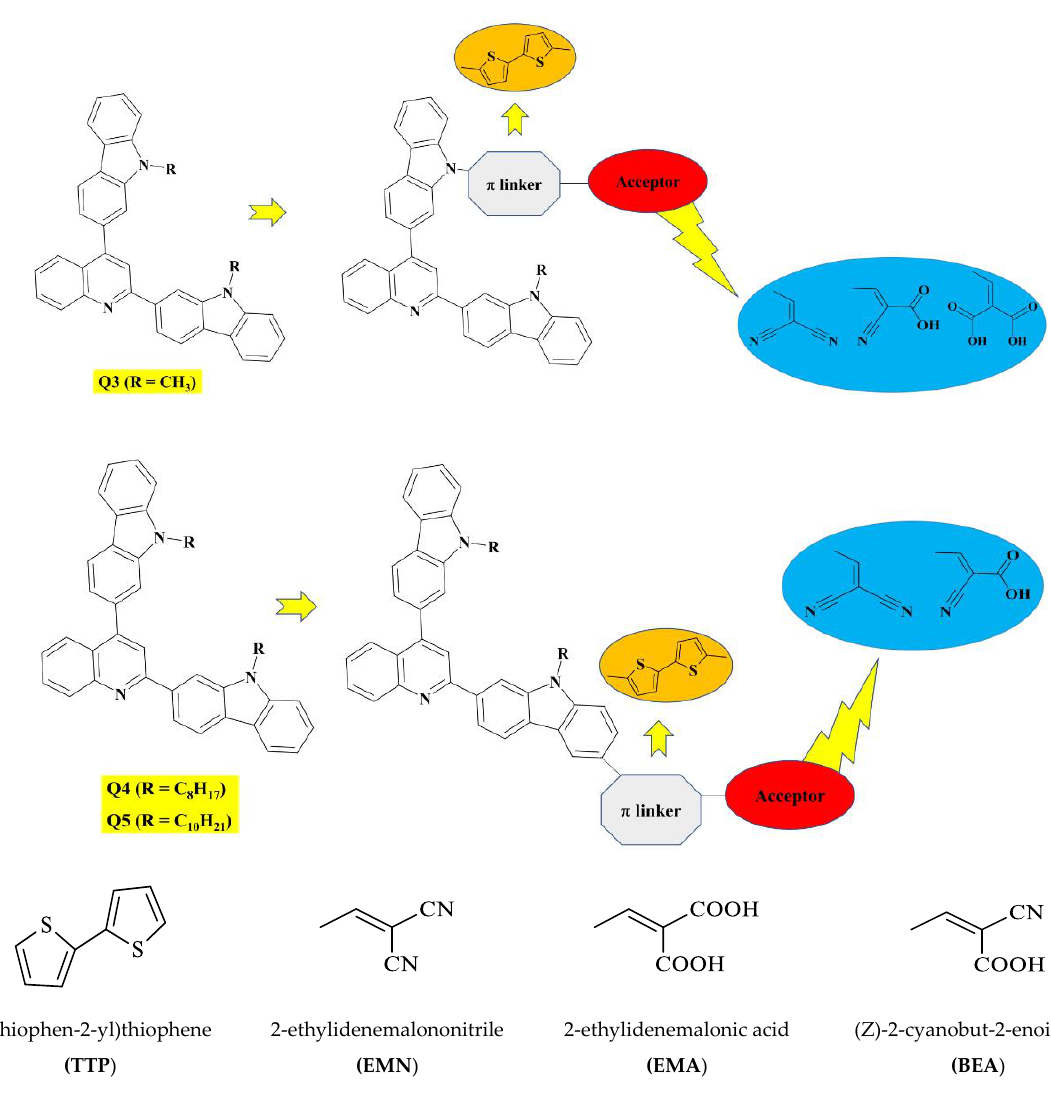
Figure 1 . Scheme and structures of spacer and different terminal acceptors used in the designed compounds Q3 , Q4 , and Q5 .